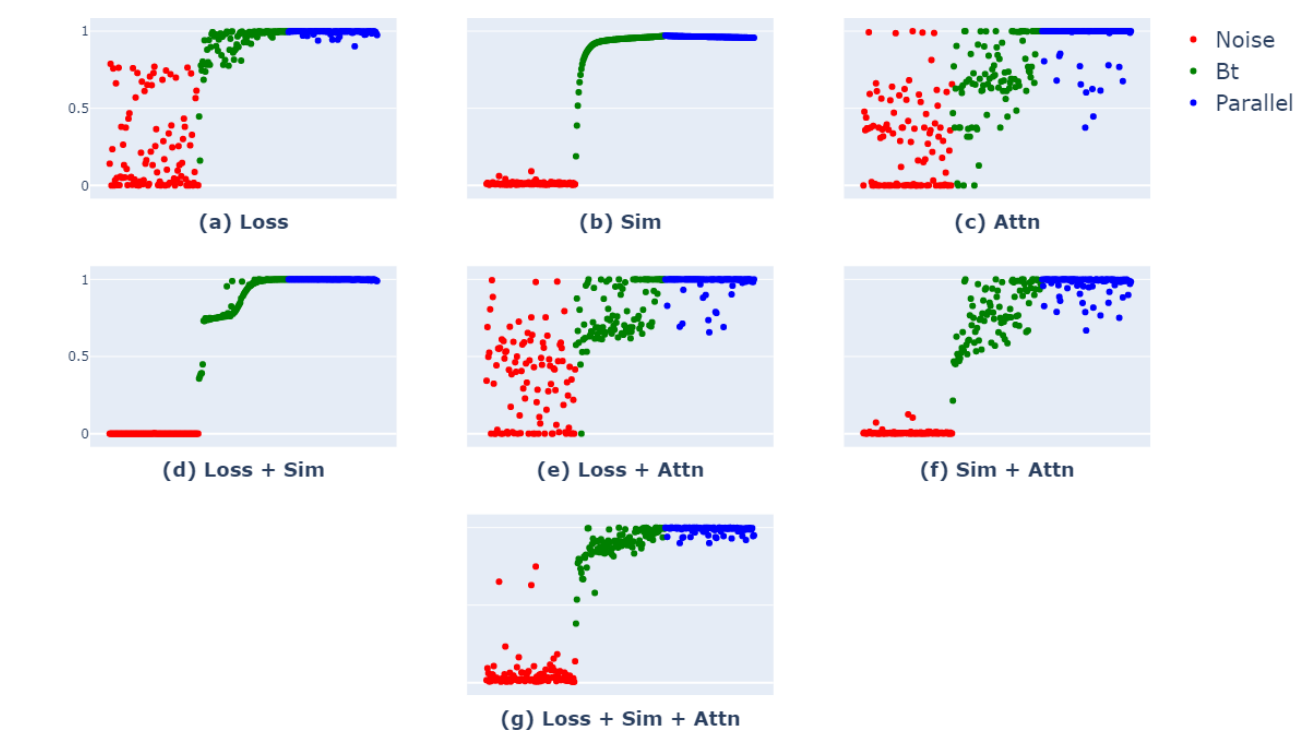
Figure 5. Distribution of weights according to the features of